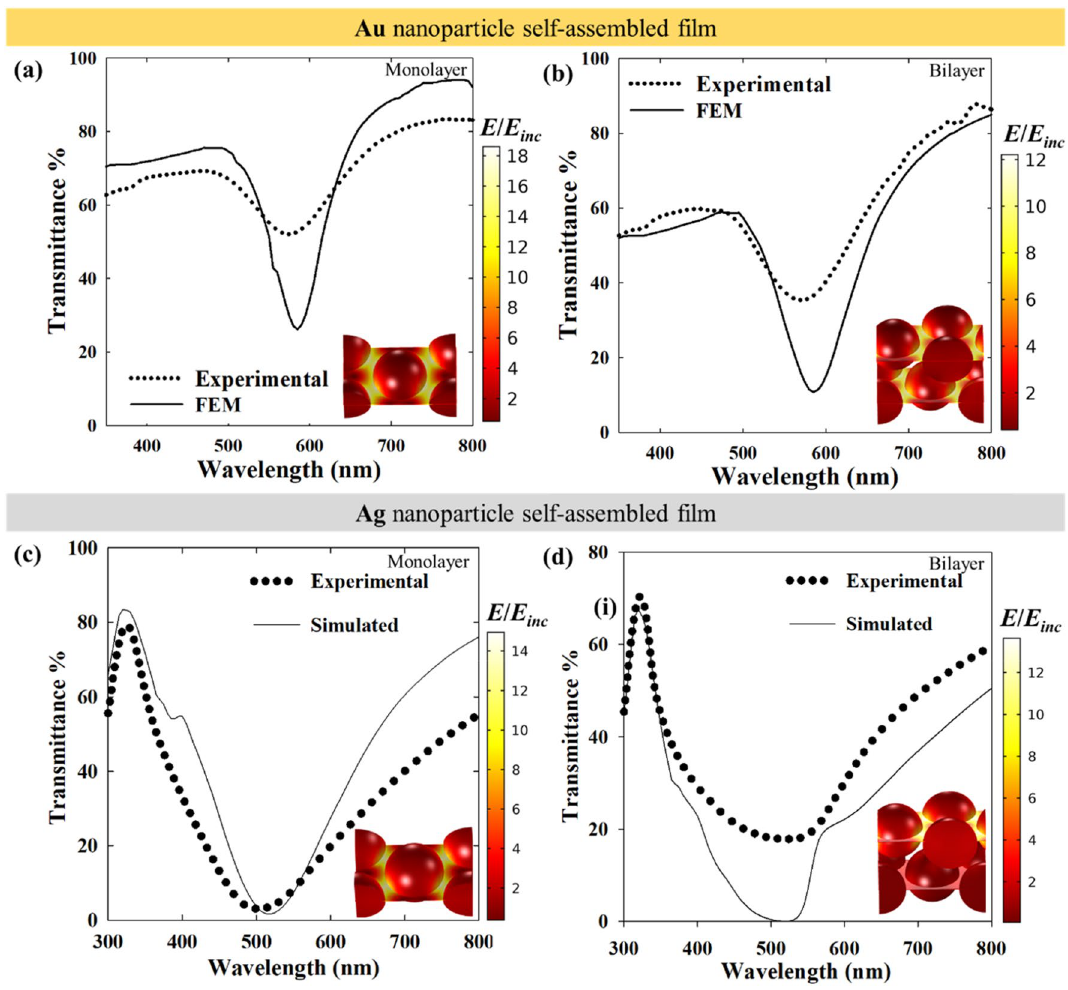
Figure 3. Experimental transmittance spectra compared with computed spectra for ( a ) Au nanoparticle monolayer, ( b ) Au nanoparticle bilayer, ( c ) Ag nanoparticle monolayer, ( d ) Ag nanoparticle bilayer. The near- field enhancement with respect to the incident field is shown in the inset of each plot. The dimensions for the models were taken from the TEM images (Fig. 2). Au nanoparticle diameter and interparticle gap: 10 nm and 2 nm, Ag nanoparticle diameter and interparticle gap: 20 and 2 nm. The direction of incidence of illumination is normal in all